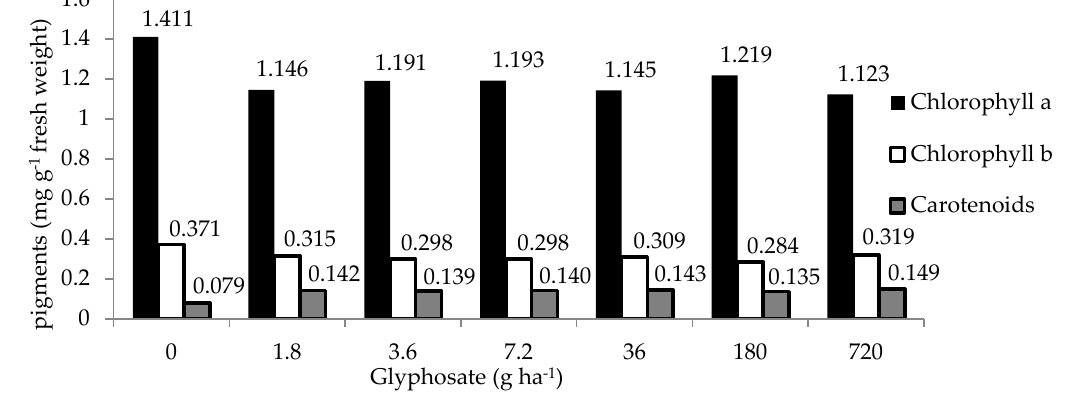
Figure 5. Effect of different glyphosate doses on photosynthetic pigments of soybean. Figure 5. E ff ect of di ff erent glyphosate doses on photosynthetic pigments of soybean.